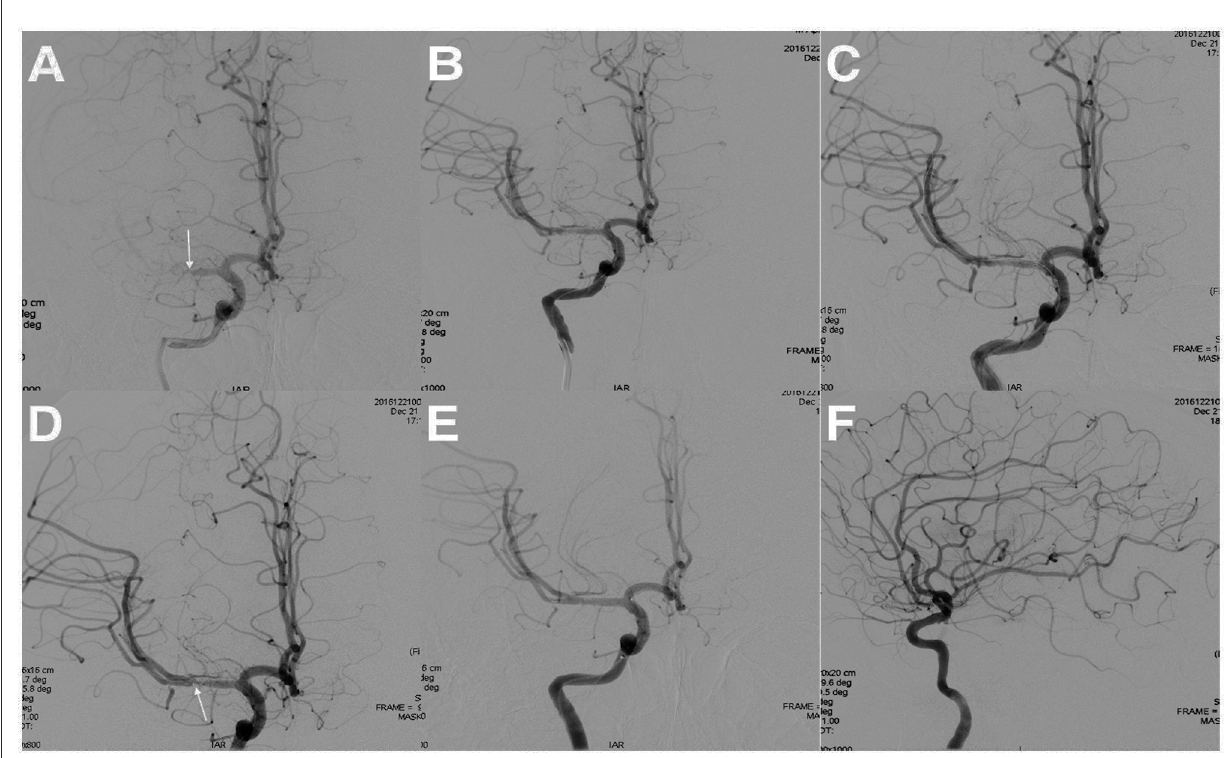
FIGURE3 Intraoperative angiographic results in a patient with acute thrombosis. (A) Middle cerebral artery occlusion (the arrow indicates the occlusion site). (B) Angiographic result after predilation with a conventional balloon. (C) Angiographic result after stenting implantation. (D) Angiographic result after 10min of stent implantation (the arrow indicates acute thrombosis). (E, F) Angiographic result after combined application of tirofiban via artery and